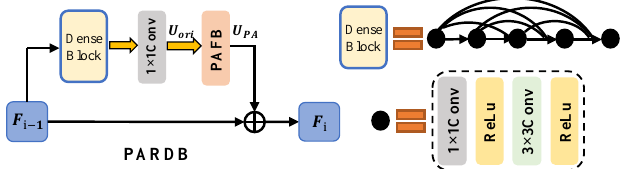
Figure 3. Diagram of PARDB, which is composed of PAFB and Dense